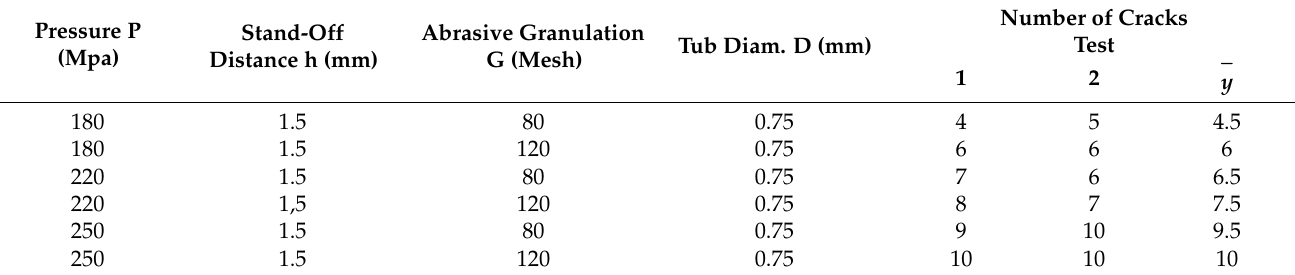
Table 4. Number of cracks depending on pressure and abrasive granulation.